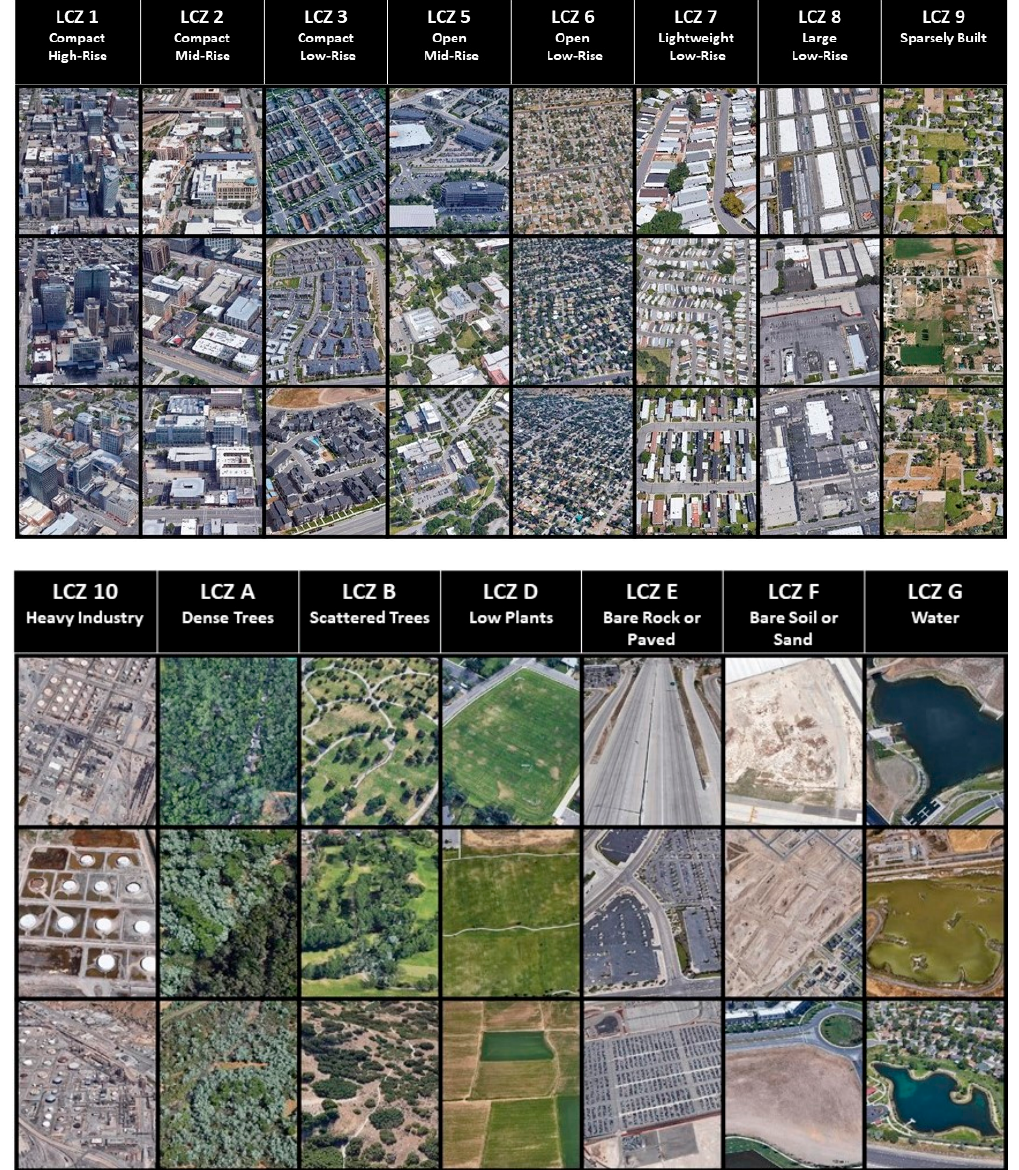
Figure A1. Examples of spatial patterns of di ff erent LCZs from high-resolution reference